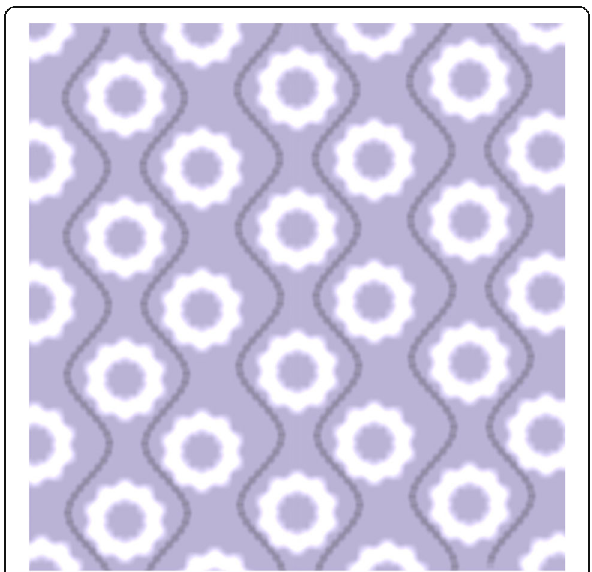
Fig. 6 Circle pattern (computer simulation tie-dye pattern). (The second is to use the Photoshop computer software painting